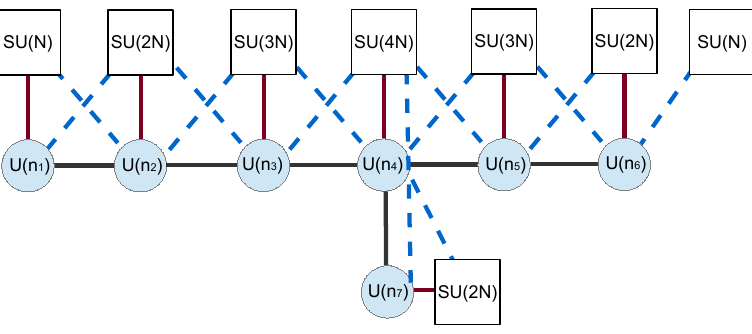
Figure 13 . Quiver gauge theory for the non-critical strings of N D5 branes probing an E singularity.